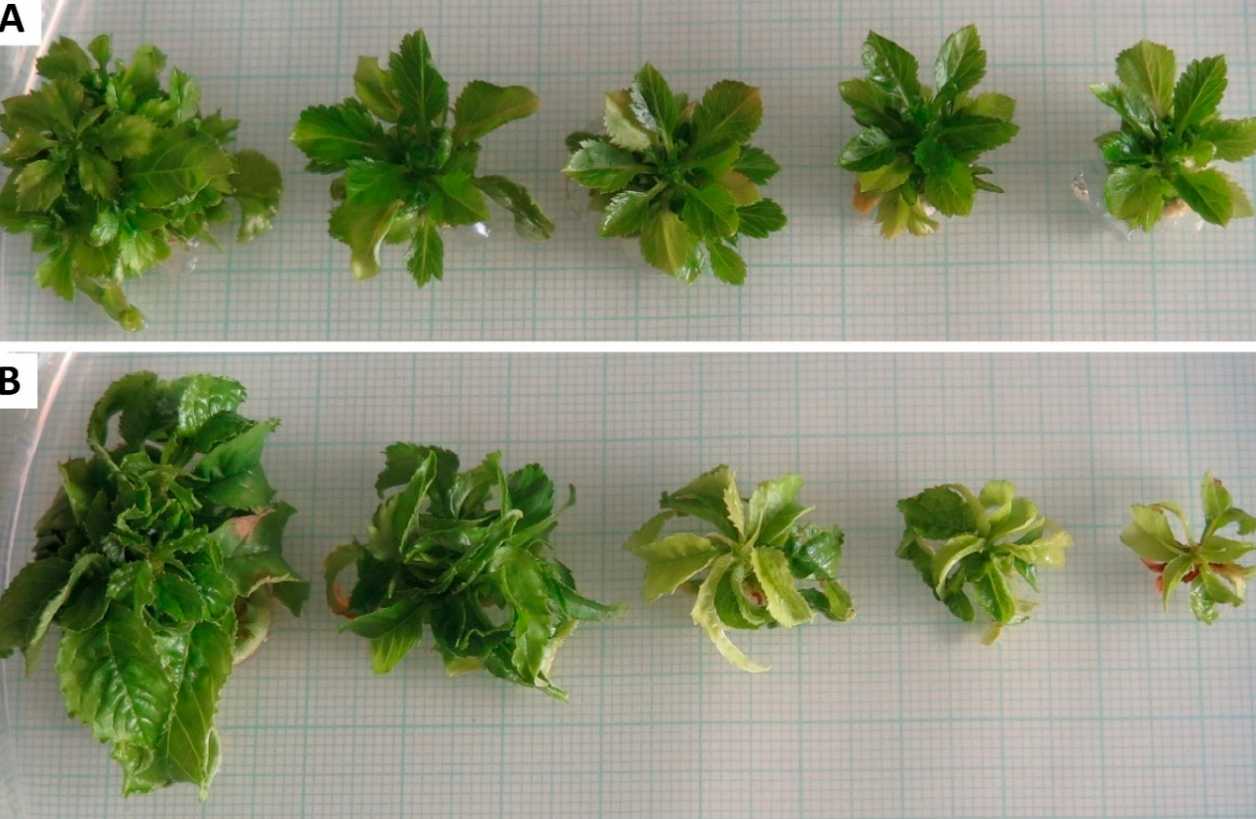
Figure 1. Effect of different concentration of polyethylene glycol (PEG-6000) on the growth and appearance of the in vitro culture of apple cultivar “Rubinstep” ( A ) and cherry cultivar “Kaštánka” ( B ); PEG concentration in g L − 1 increasing from left to right (PEG0, PEG5, PEG10, PEG25, PEG50).